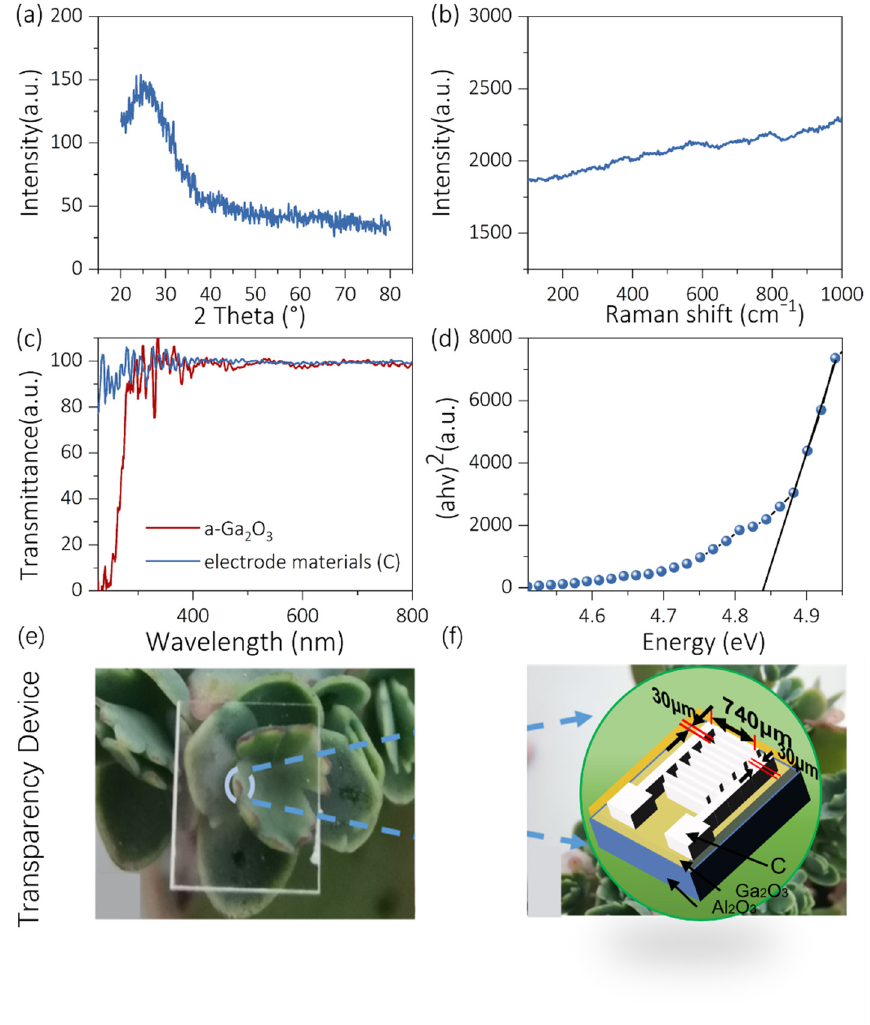
Figure 1. ( a ) XRD diffraction pattern and ( b ) Raman spectra of gallium oxide films; ( c ) transmission spectra of the gallium oxide film and electrode materials; ( d ) optical bandgap of gallium oxide film form Tuac formula; ( e ) the original photograph of the fully transparent device; ( f ) the graphic views of the device.